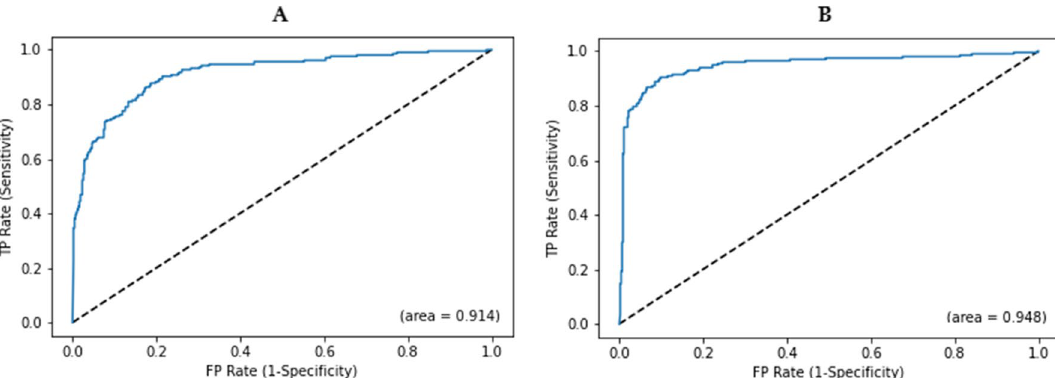
Figure 3. Receiver operating characteristic (ROC) curves of AptaNet before and after the feature selection on our benchmark dataset. Where ( A ) depicts the prediction performance of AptaNet before using feature selection and ( B ) illustrates the prediction performance of AptaNet after using feature selection. FP False Positive rate, TP True Positive rate.